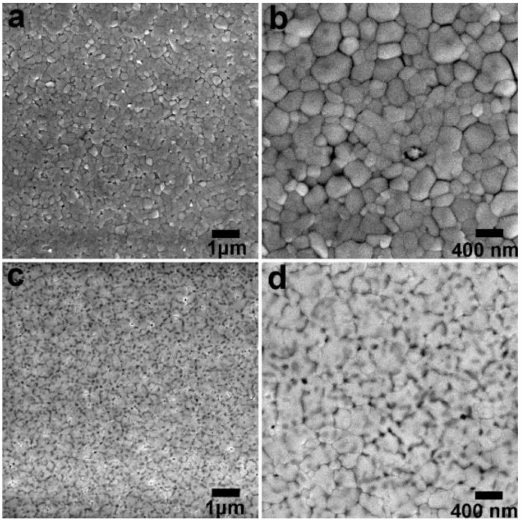
Figure 2. SEM images of perovskite film deposited on ( a , b ) perovskite film processed on a pristine PEDOT:PSS film; ( c , d ) perovskite film processed on PEDOT:PSS film with the perovskite layer rinsed away by DMSO with high magnification,